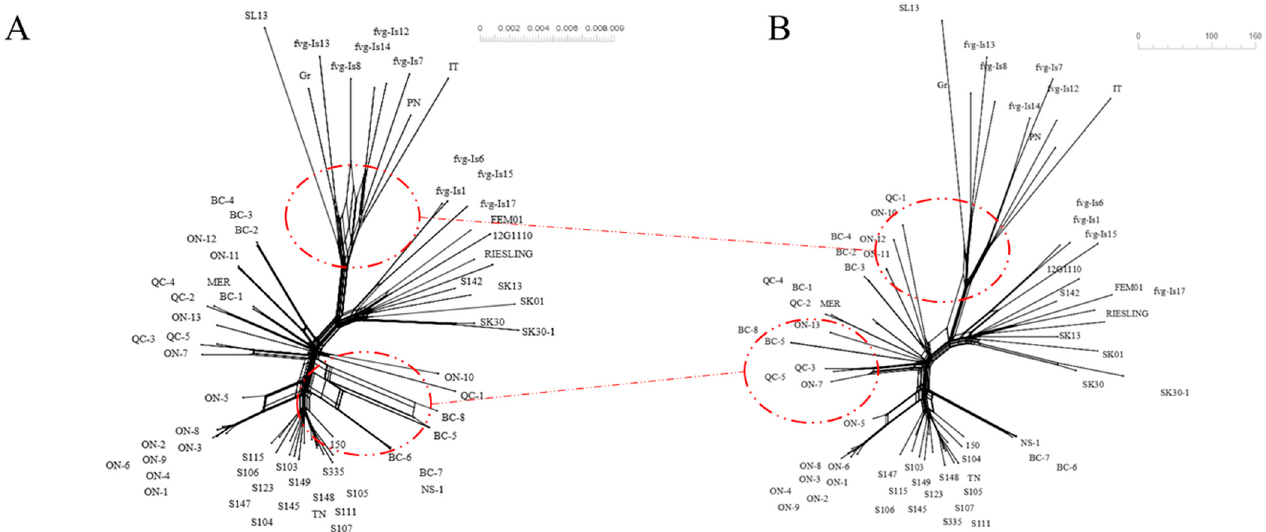
Figure 1. Initial neighbor joining network for 64 full genomes (approximately 7300 bp, ( A )/left) and for the 64 largest recombination-free fragments (4866 bp, ( B )/right). Both trees were built using the neighbor joining network pipeline in Splittree 5.3.0, which consists of the Hamming Distances method (Hamming 1950), the Neighbor Net method (Bryant and Moulton 2004) and the Splits Network Algorithm method (Dress and Huson 2004), using all default options.